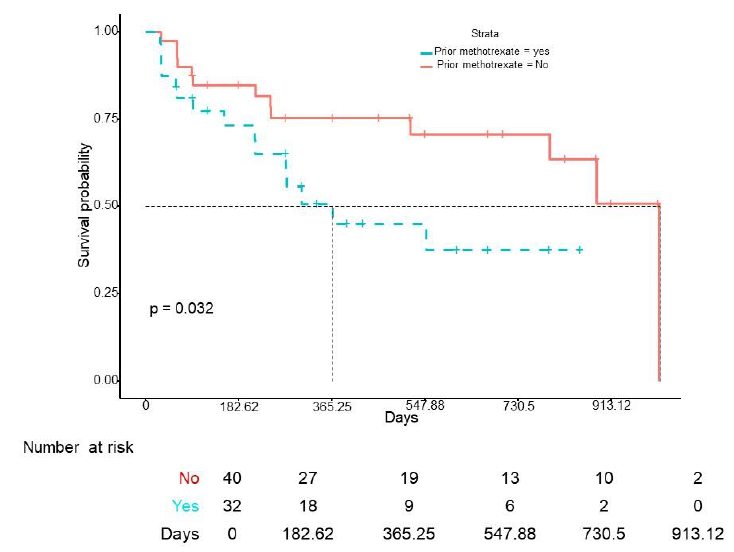
Figure 1. Ixekizumab survival curve.